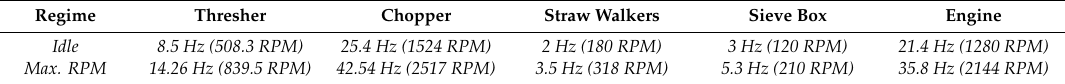
Table 2. Speeds of the components of the combine harvester at idle and at maximum RPM. Regime Thresher Chopper Straw Walkers Sieve Box Engine